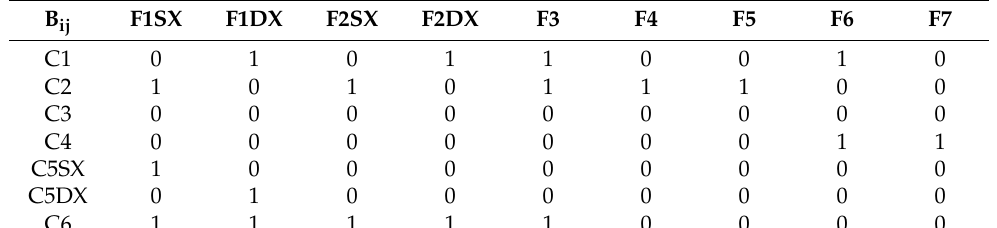
Table 4. Precedence matrix.